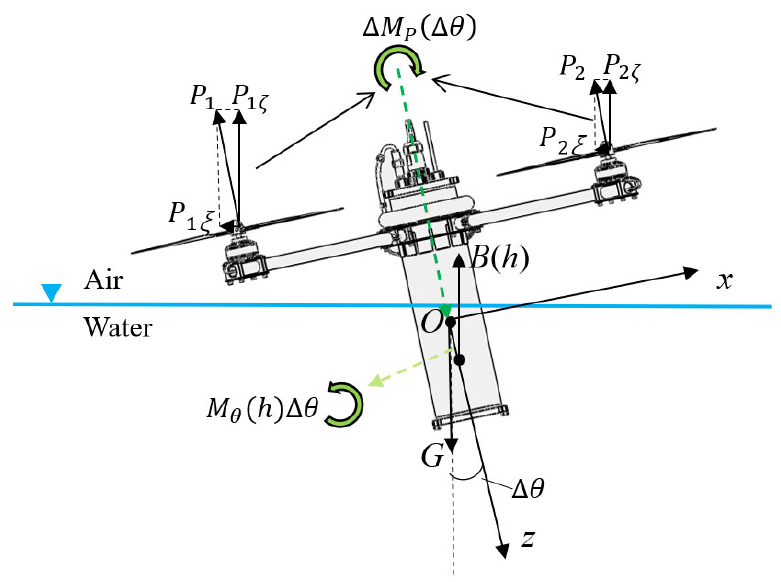
Figure 6. Static force analysis in the ξ E ζ plane.